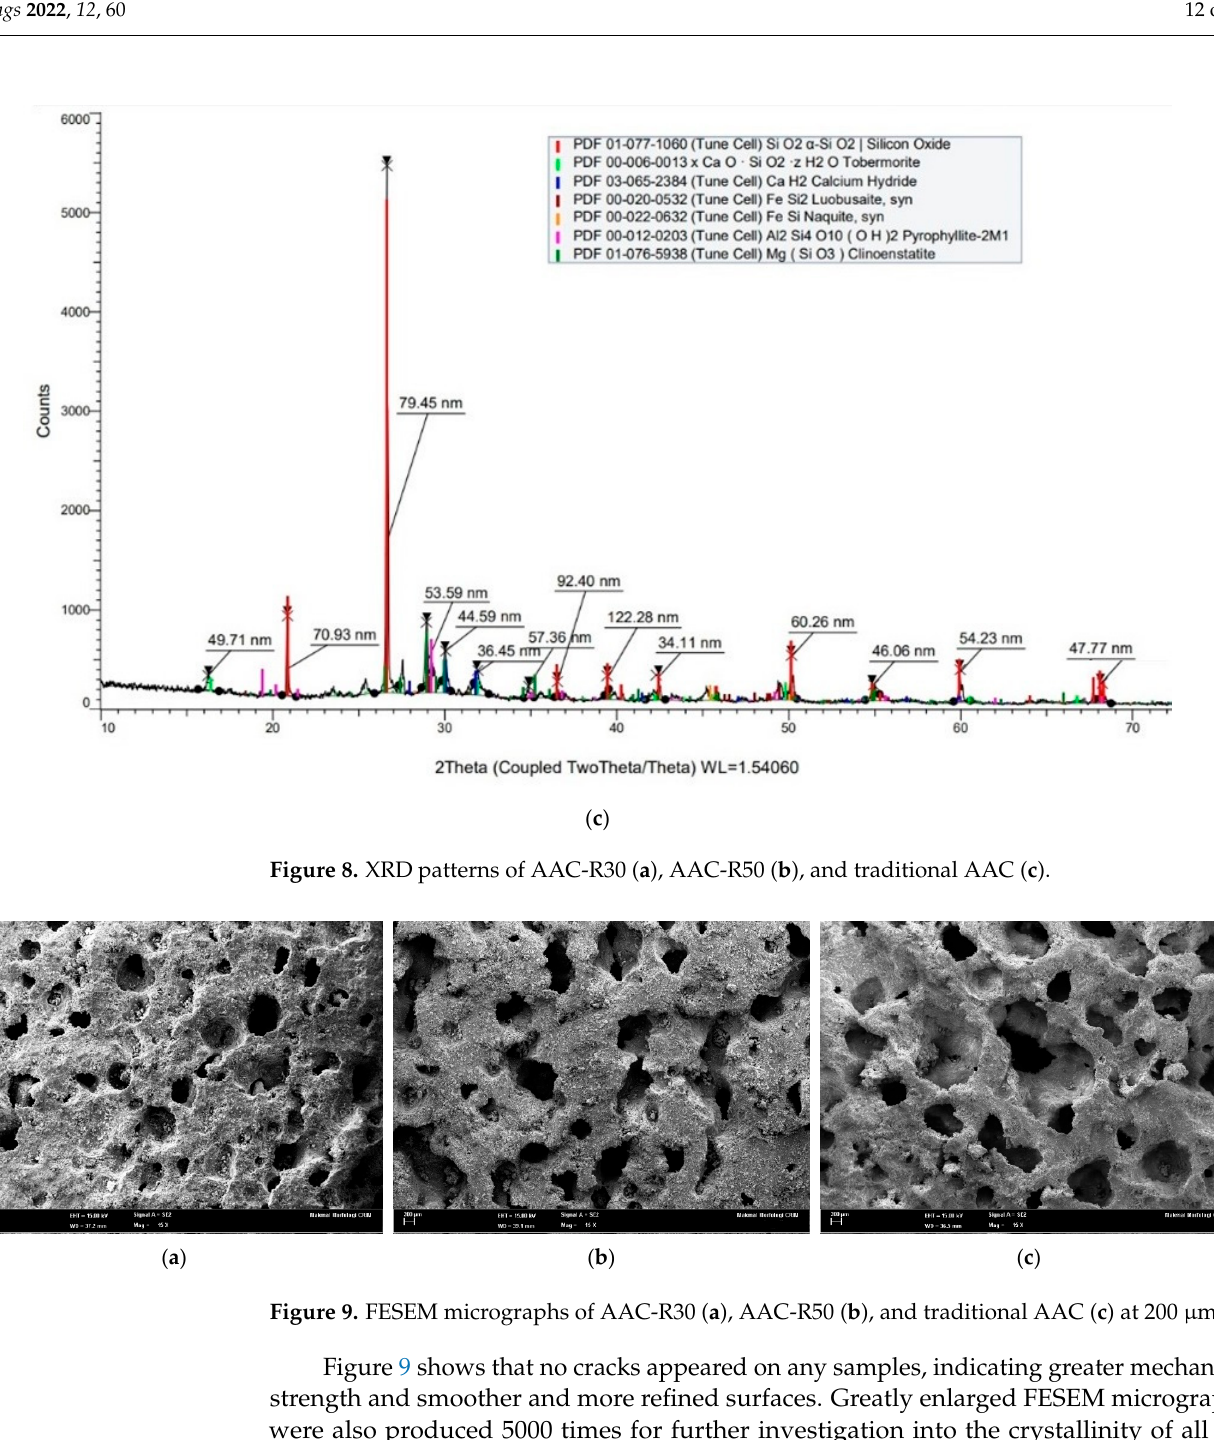
Figure 9. FESEM micrographs of AAC-R30 ( a ), AAC-R50 ( b ), and traditional AAC ( c ) at 200 µm.